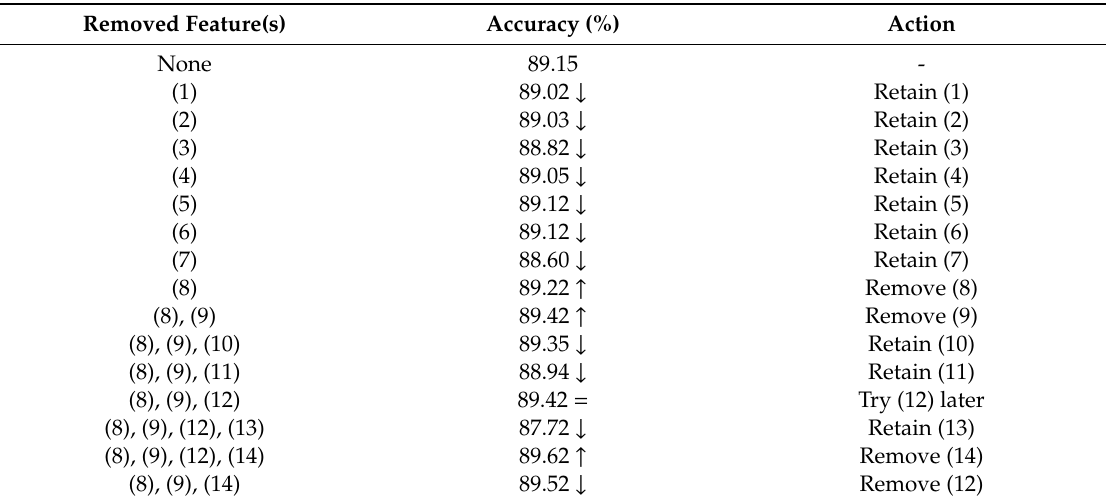
Table 2. Accuracy variation during the “backwards”